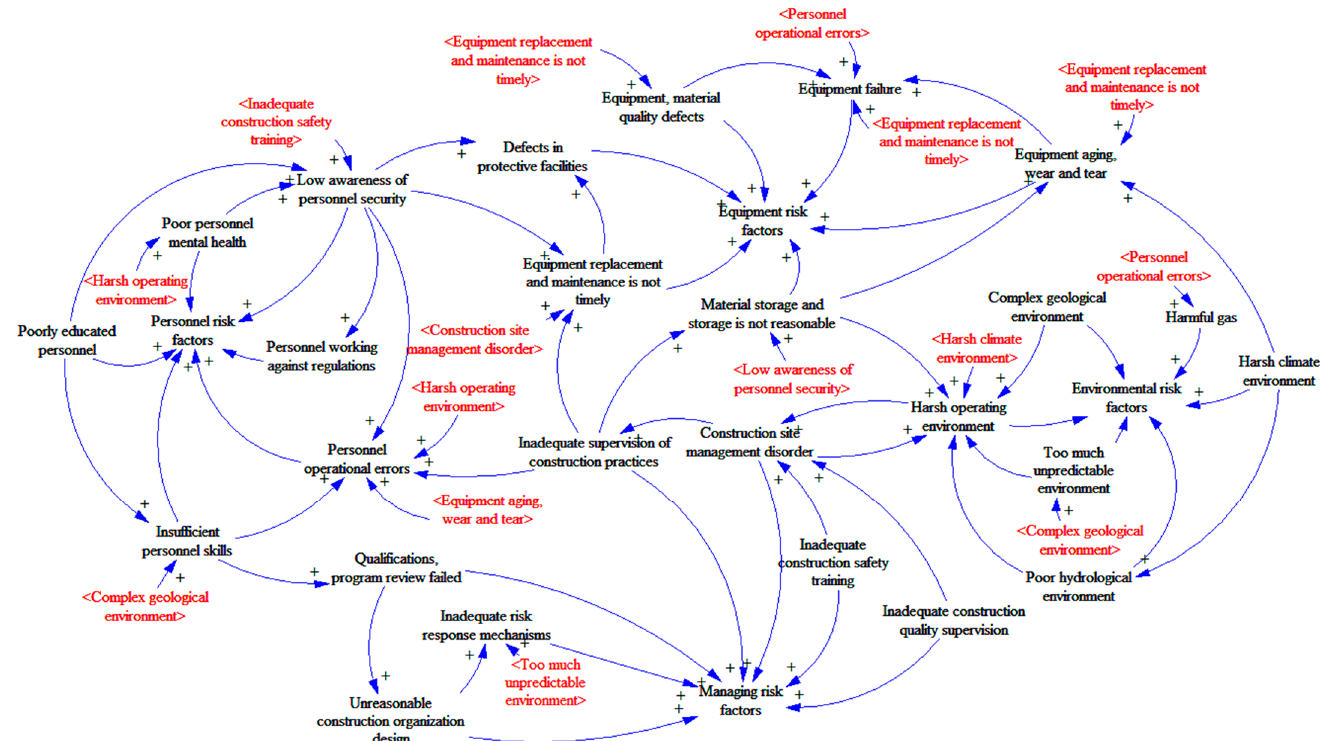
Figure 7. “Personnel–equipment–environment–management” coupling SD causality diagram.